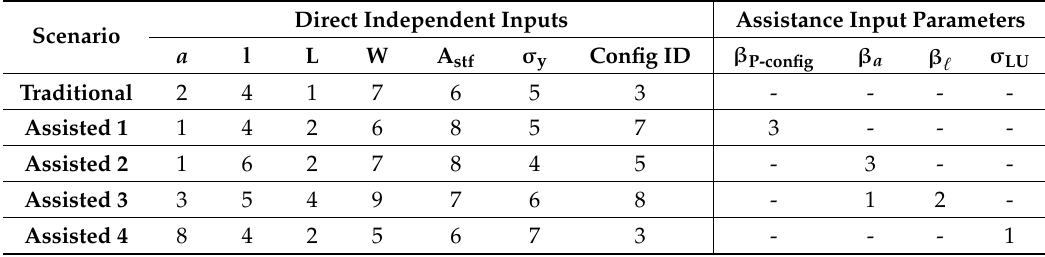
Figure 8. Normalized relative weights of the different ANN inputs for the traditional and assisted approach at the different training dataset sizes (results are based on averages for the 80 random combinations of the training dataset). Table 4. Ranking of the different ANN inputs based on their importance (relative weight) for the full size training datasets (results are based on averages for the 80 random combinations of the training dataset).